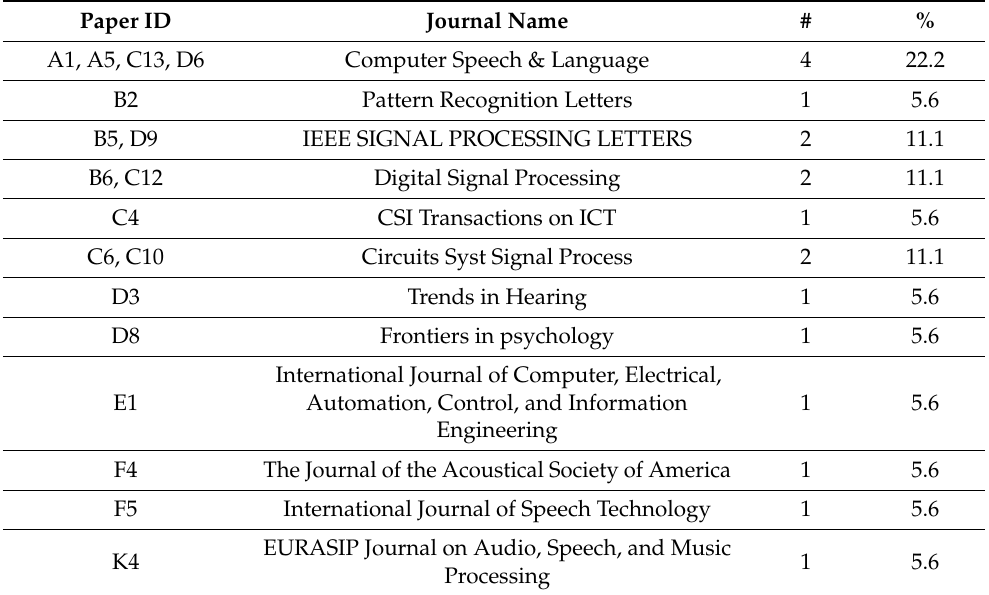
Table 4. Journal research papers included in the